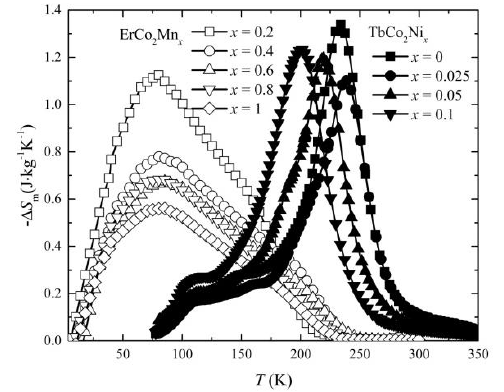
Fig. 6. Temperature dependences of entropy change of ErCo 2 Mn x and TbCo 2 Ni x compounds for magnetic field change µ 0 Δ H = 1